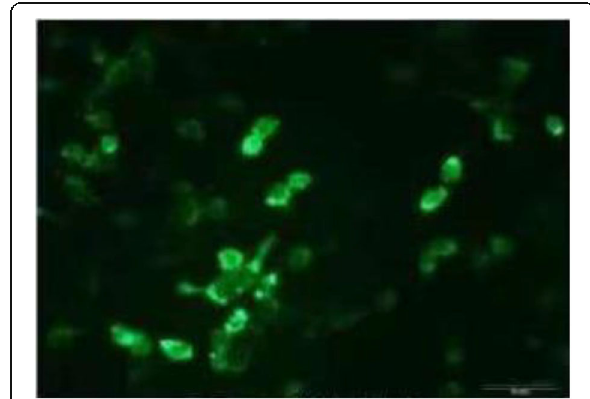
Fig. 2 The result of anti-leucine-rich, glioma inactivation-1 antibody. A 4-year-old girl with positive serum anti-leucine-rich, glioma inactivation-1 antibody on indirect immunofluorescence test (green